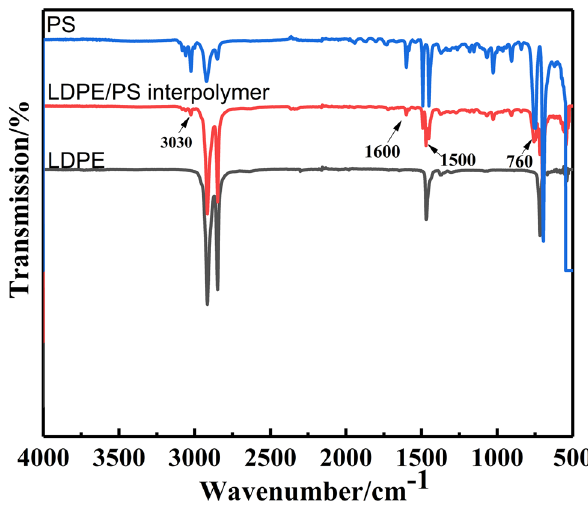
Figure 4: FTIR spectra of LDPE, PS, and LDPE/PS interpolymer resin particles.